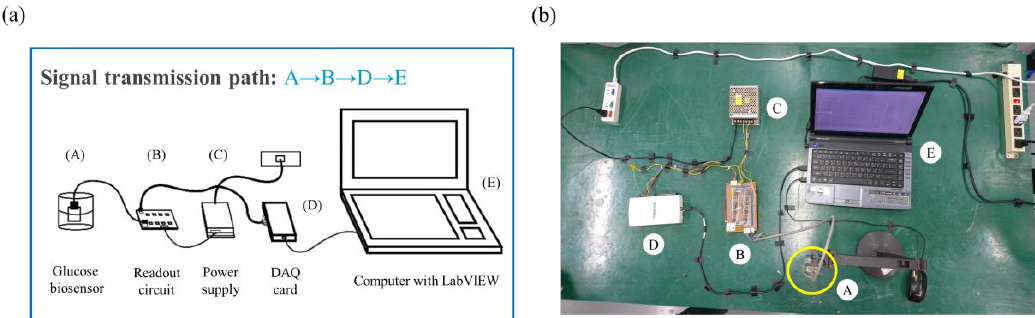
Figure 2. Experimental system diagram of the voltage – time (V-T) measurement system: ( a ) schematic view and ( b ) experimental setup.